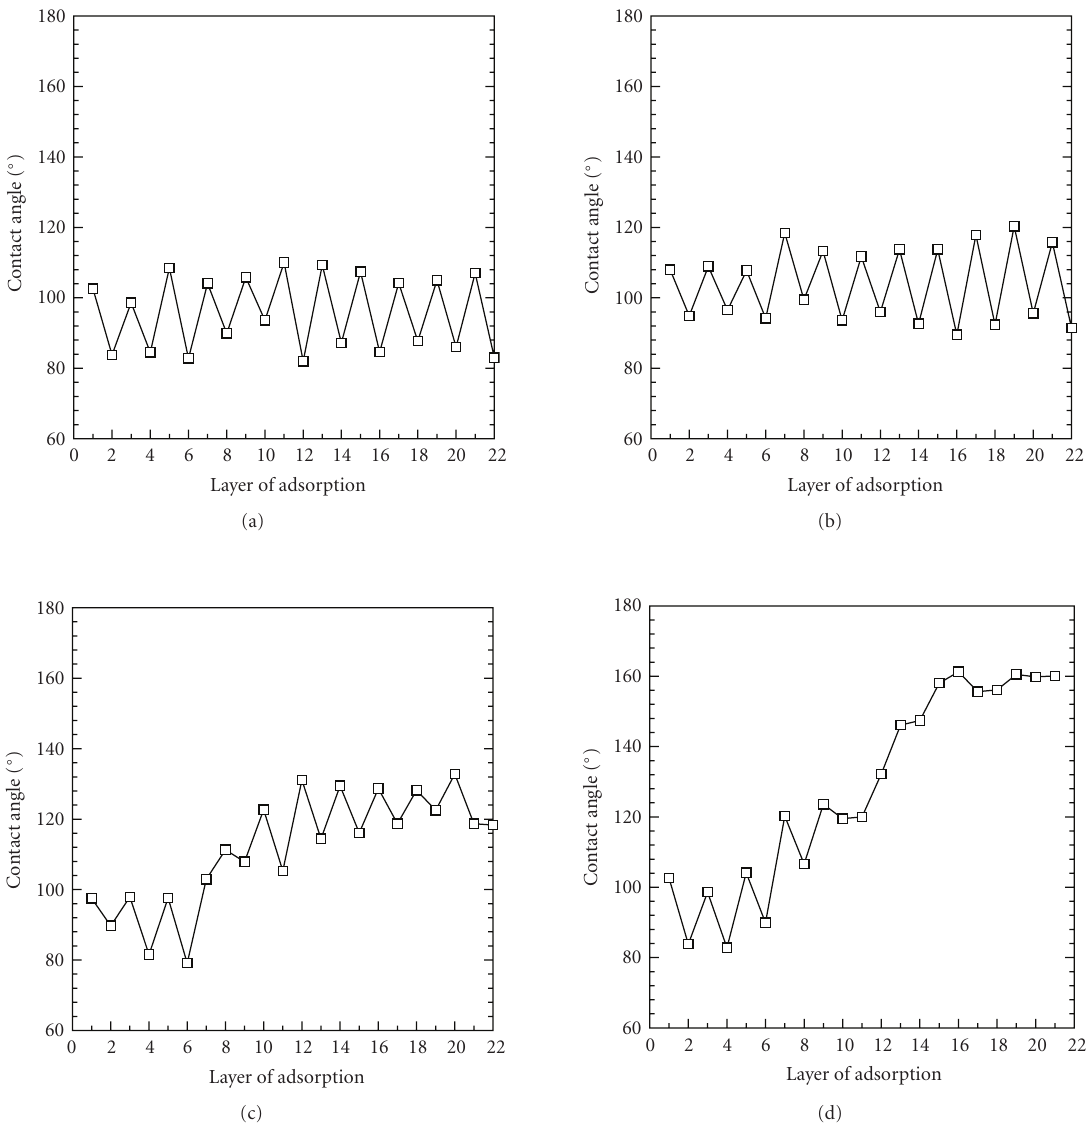
Figure 4: Static contact angles of water droplets on the alternately deposited PDMS-1/PDMS-2 (old numbers for PDMS-2 and even numbers for PDMS-1) multilayer film after each layer of deposition prepared from 0.025 M phosphate bu ff er (a), 0.005 M phosphate bu ff er (b), 0.001 M phosphate bu ff er (c), and water solution (d).